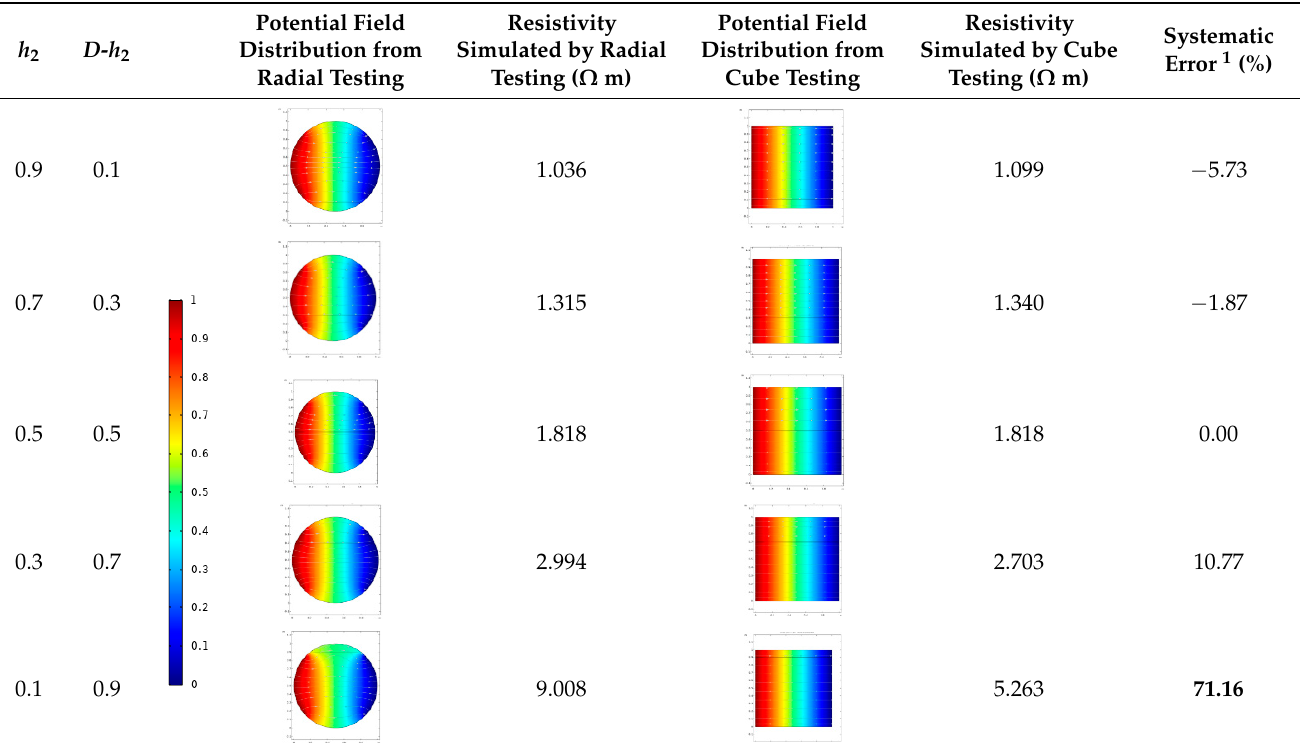
Table 1. Extreme 2: numerical simulation results of different material thicknesses.